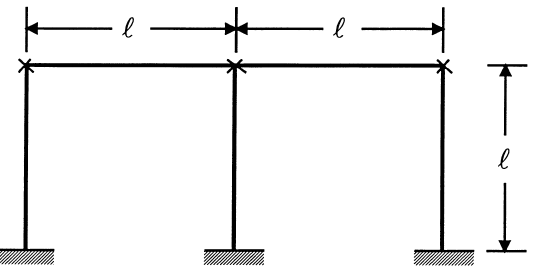
Fig. 1. Plane frame example. Crosses denote the joints at which lumped masses or rotatory inertias were optionally added. The test structure is the two-bay single storey rigidly jointed plane frame with identical and inextensible members shown in Fig. 1. Extra joints were introduced at the beam and column mid-lengths to ensure accu- rate computation of modes such as those of Fig. 3 be- low, which would otherwise have D = 0 .